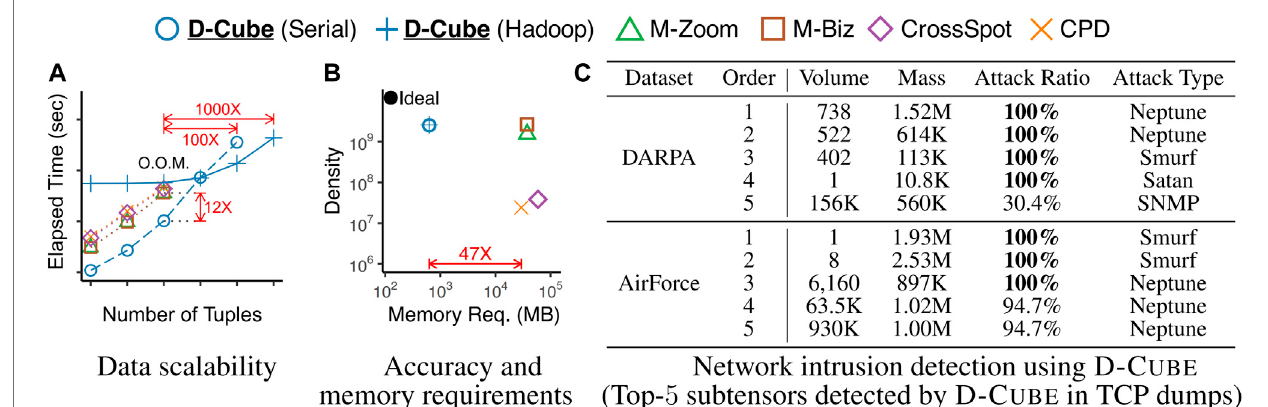
FIGURE 1 | Strengths of D-CUBE . ‘ O.O.M ’ stands for ‘ out of memory ’ . (A) Fast and Scalable: D-CUBE was 12 × faster and successfully handled 1,000 × larger data (2.6TB) than its best competitors. (B) Ef fi cient and Accurate: D-CUBE required 47 × less memory and found subtensors as dense as those found by its best competitors